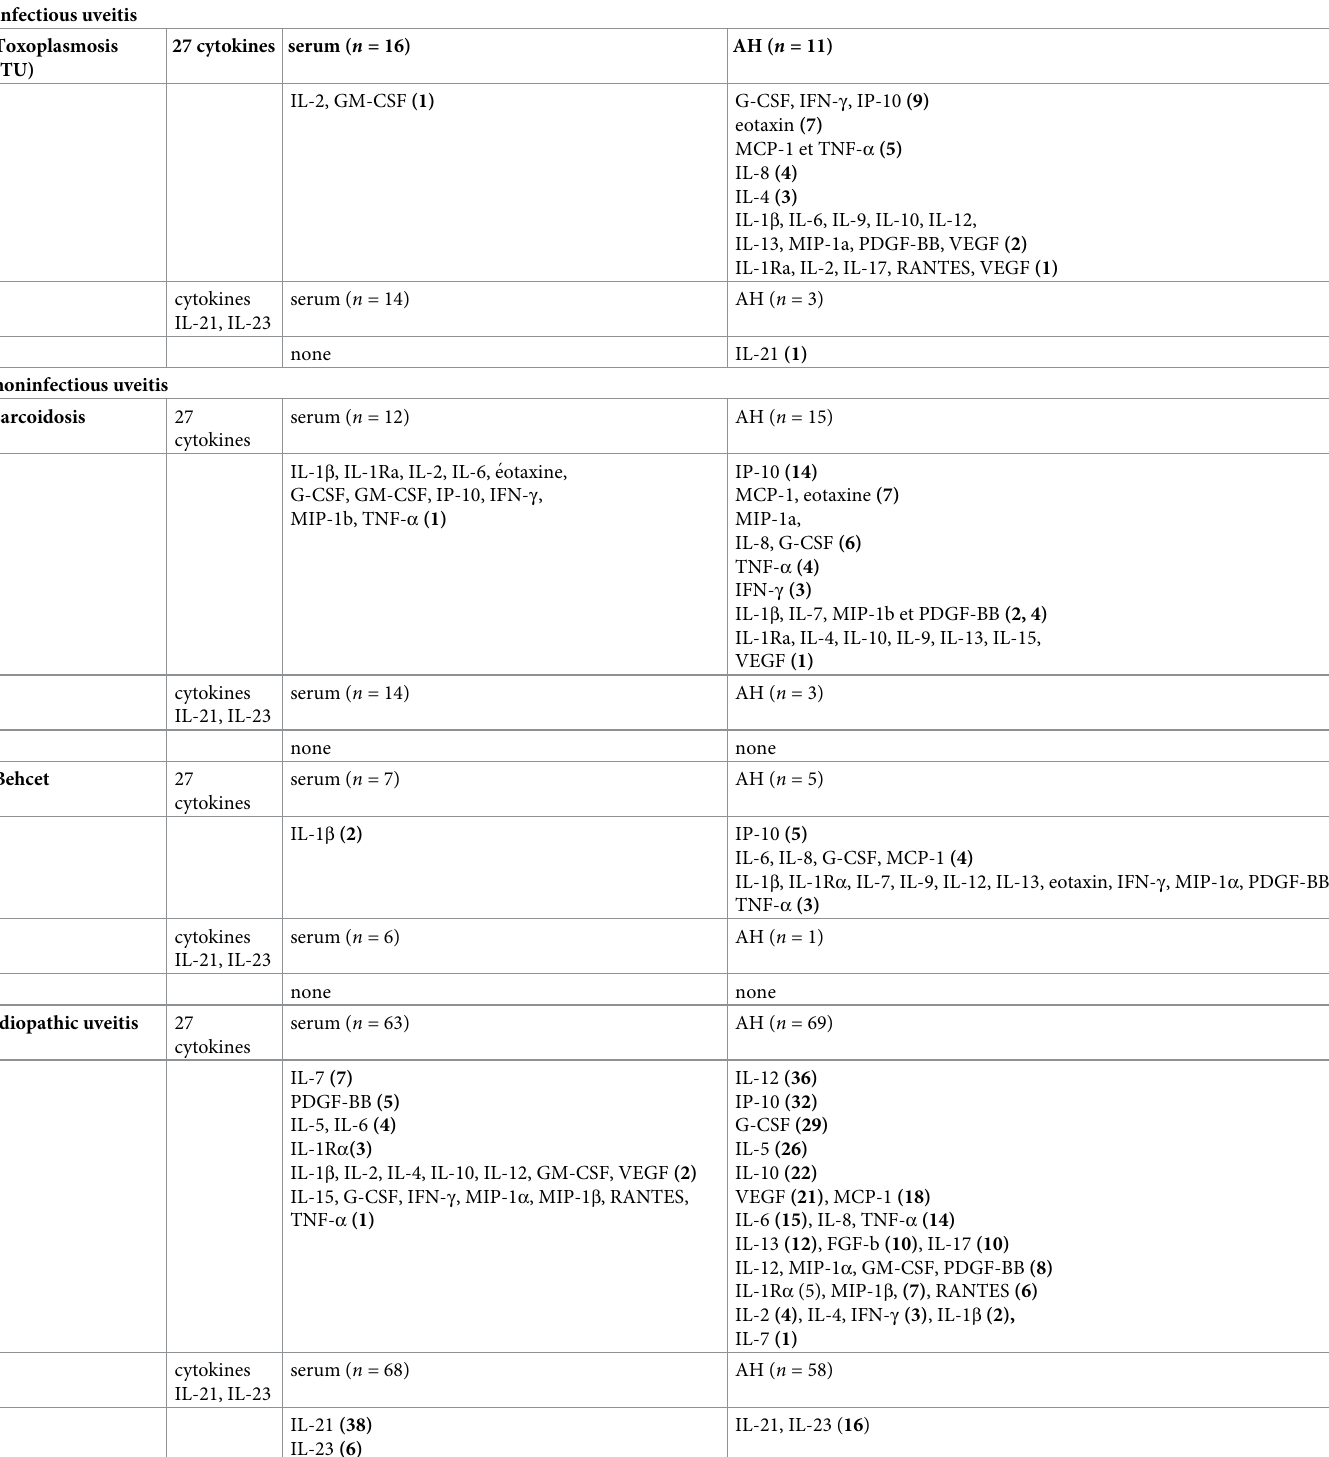
Table 4. Immune mediator expression (cytokines, chemokines and growth factors) elevated in patients with idiopathic uveitis and disease control groups (infec- tious and noninfectious uveitis) as compared with noninflammatory controls ( n = number of patients). The numbers in brackets represent the number of samples for which the mediator result was found to be